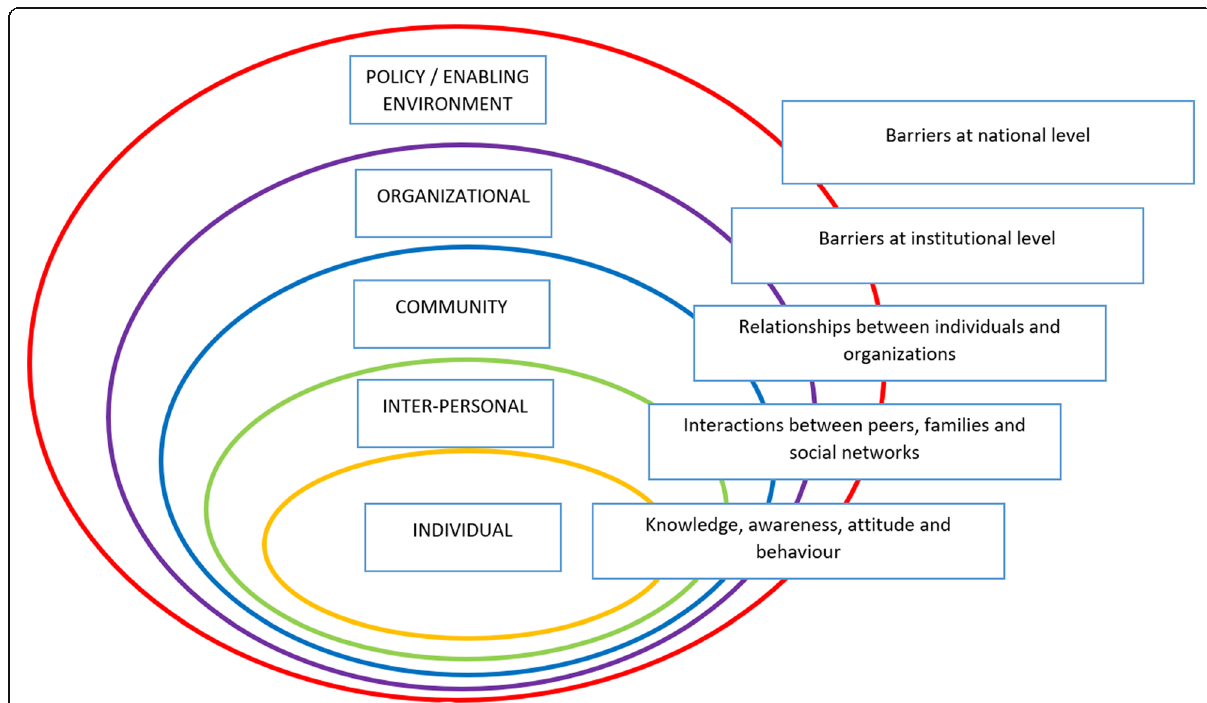
Fig. 1 Illustration of socio-ecological model to understand interactions of PwDM and environment depicting barriers at each